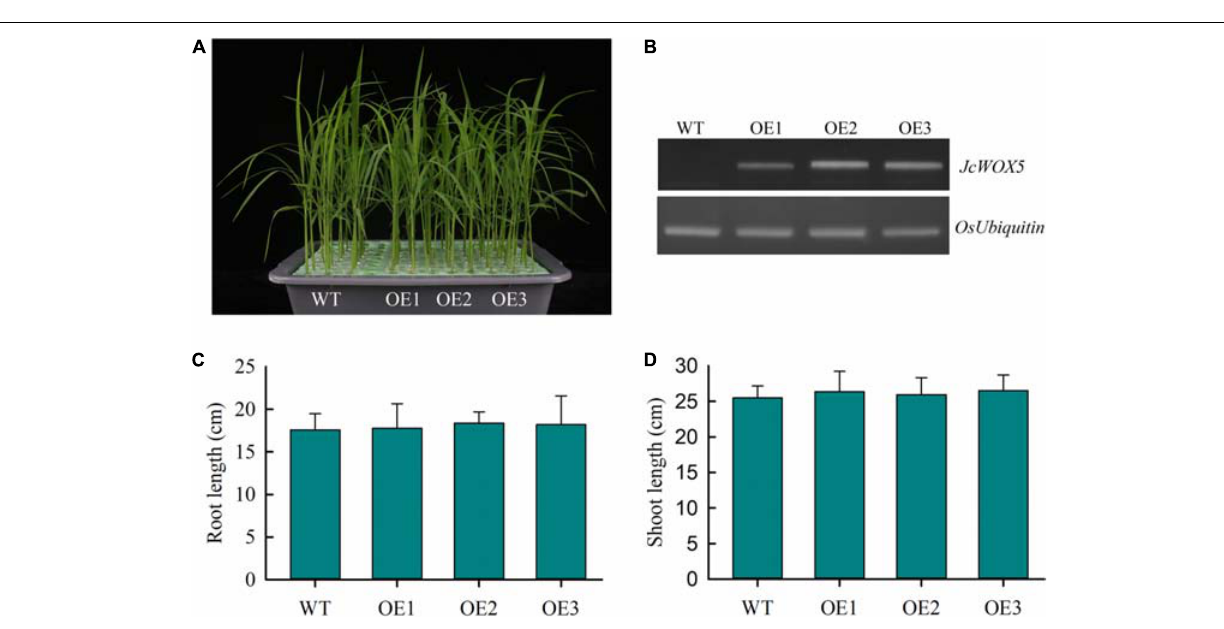
FIGURE 7 | Characterization of JcWOX5 transgenic plants (OE1, OE2, and OE3) and their growth phenotypes. (A) Growth phenotype of 2-week-old wild-type and JcWOX5 transgenic plants under normal growth conditions. (B) Levels of JcWOX5 transcript in wild-type and transgenic lines. (C) Root length in